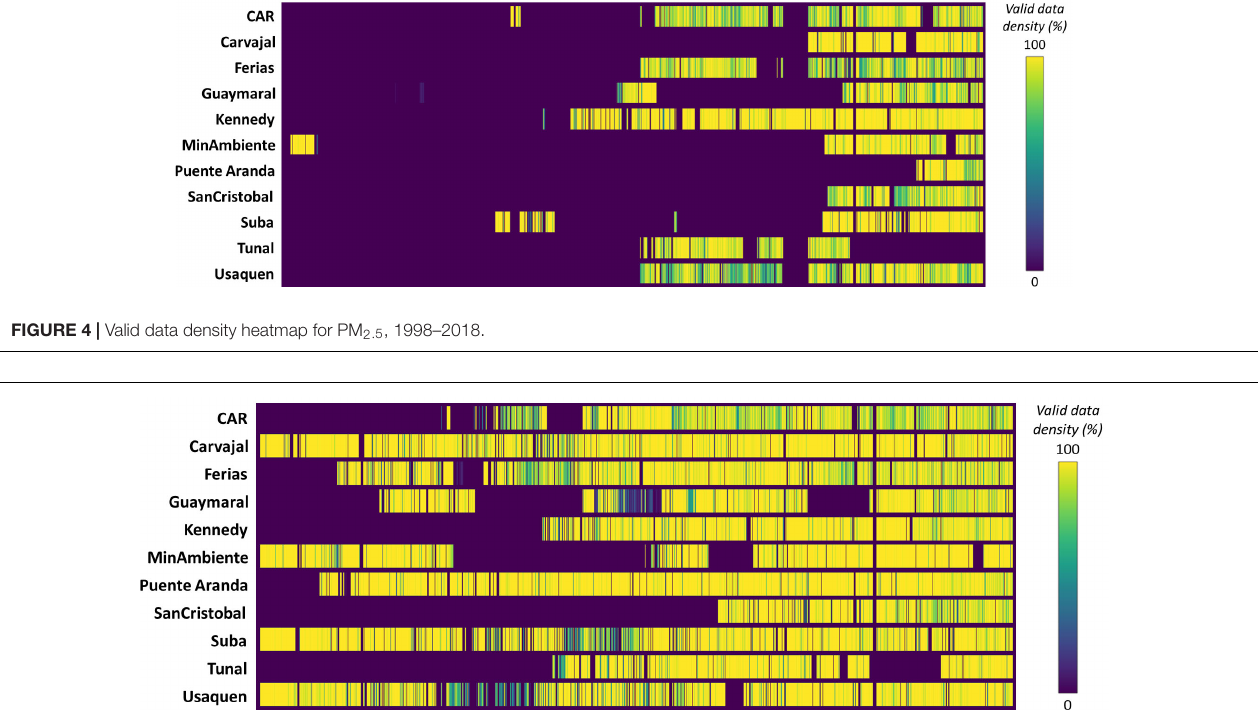
FIGURE 5 | Valid data density heatmap for PM 10 ,